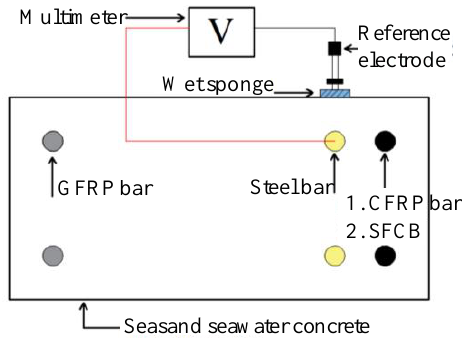
Figure 7. Schematic diagram of the potential